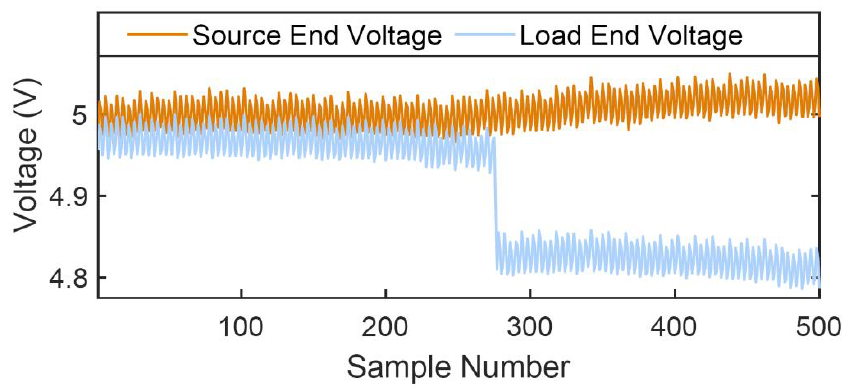
Figure 5. Event 1: data used for series arc fault analysis—voltages at the source and load